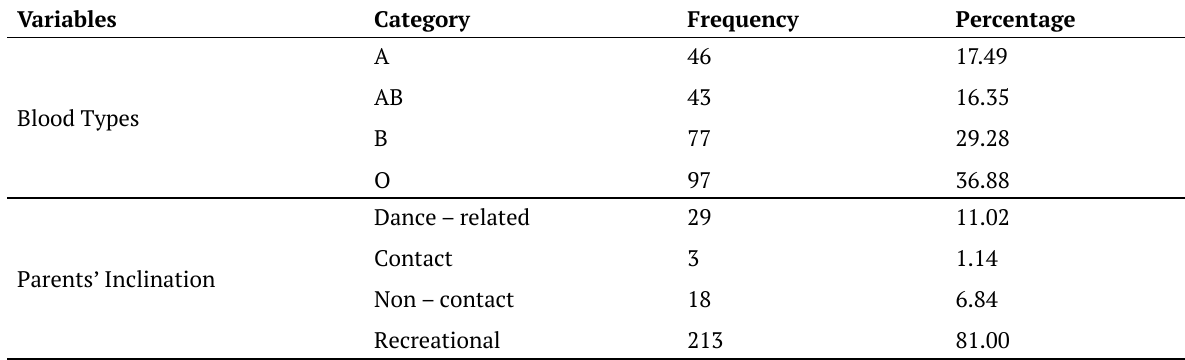
Table 2. Blood types and parents’ inclination to physical